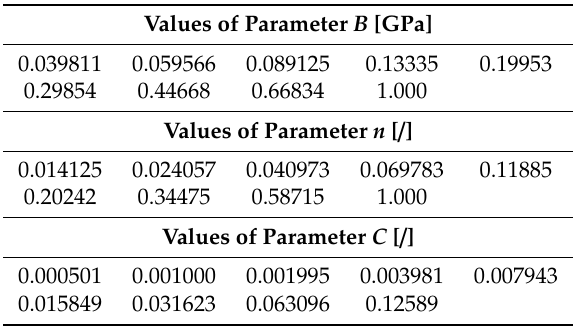
Table 3. Parameters levels for the Taguchi array